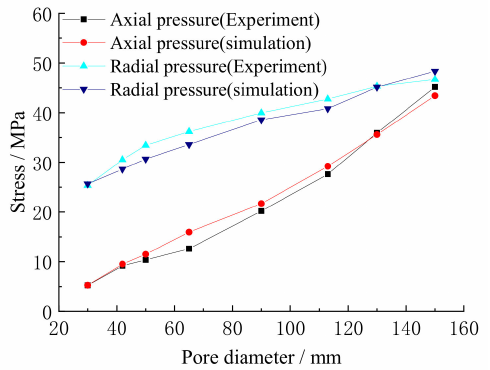
Figure 13. Radial and axial pressures for models with varying cylinder